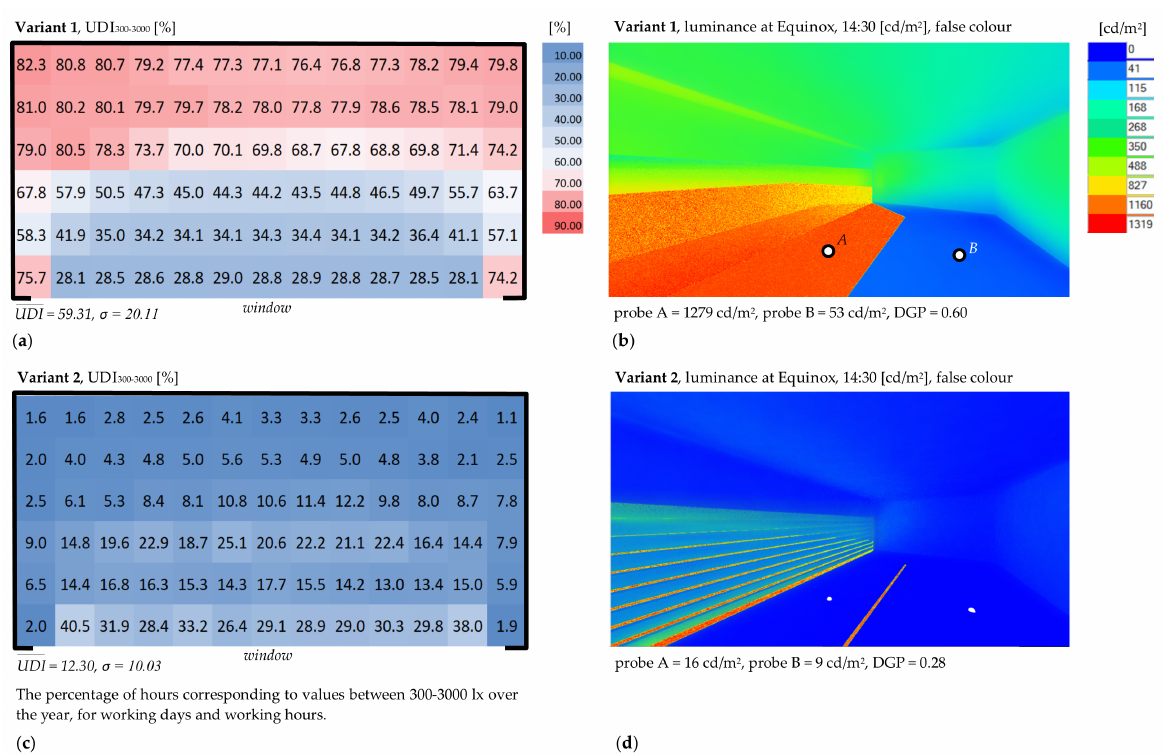
Figure 5. Results of the first phase of the simulation: ( a , c ) test room plan and spatial distribution of UDI 300–3000 over the test year (%); ( b , d ) luminance values for equinox, at 14:30 (cd/m 2 ) for Variants 1 and 2. Scale is given respectively on the Figure. Exact values are given in the data file in Supplementary